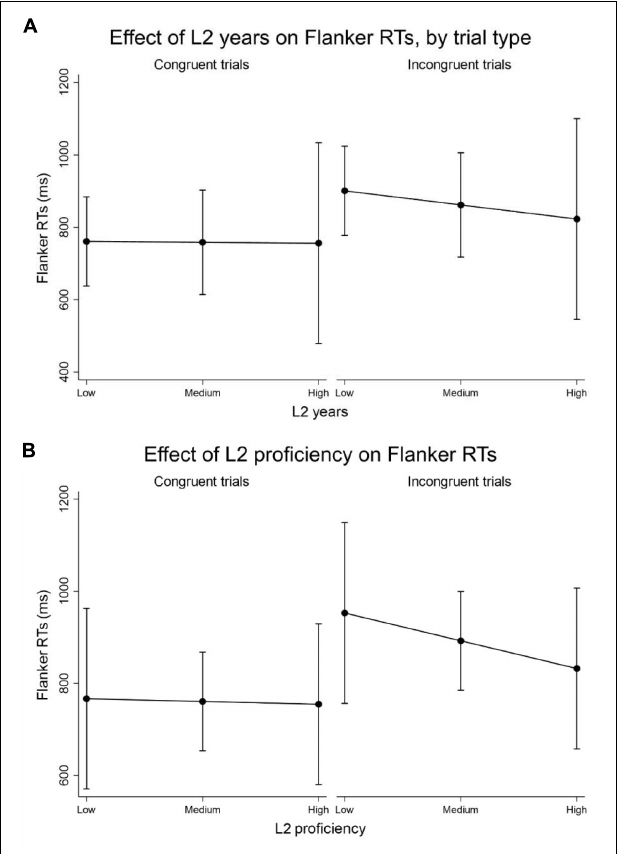
FIGURE 3 | (A) Interaction plot for the L2 years * trial type interaction predicting Flanker RTs (in ms). Increasing levels of time passed since acquiring L2 predict lower RTs, i.e., better inhibitory executive performance; (B) interaction plot for the L2 proficiency * trial type interaction predicting Flanker RTs (in ms). Increasing levels of L2 proficiency predict lower RTs, i.e., better inhibitory executive